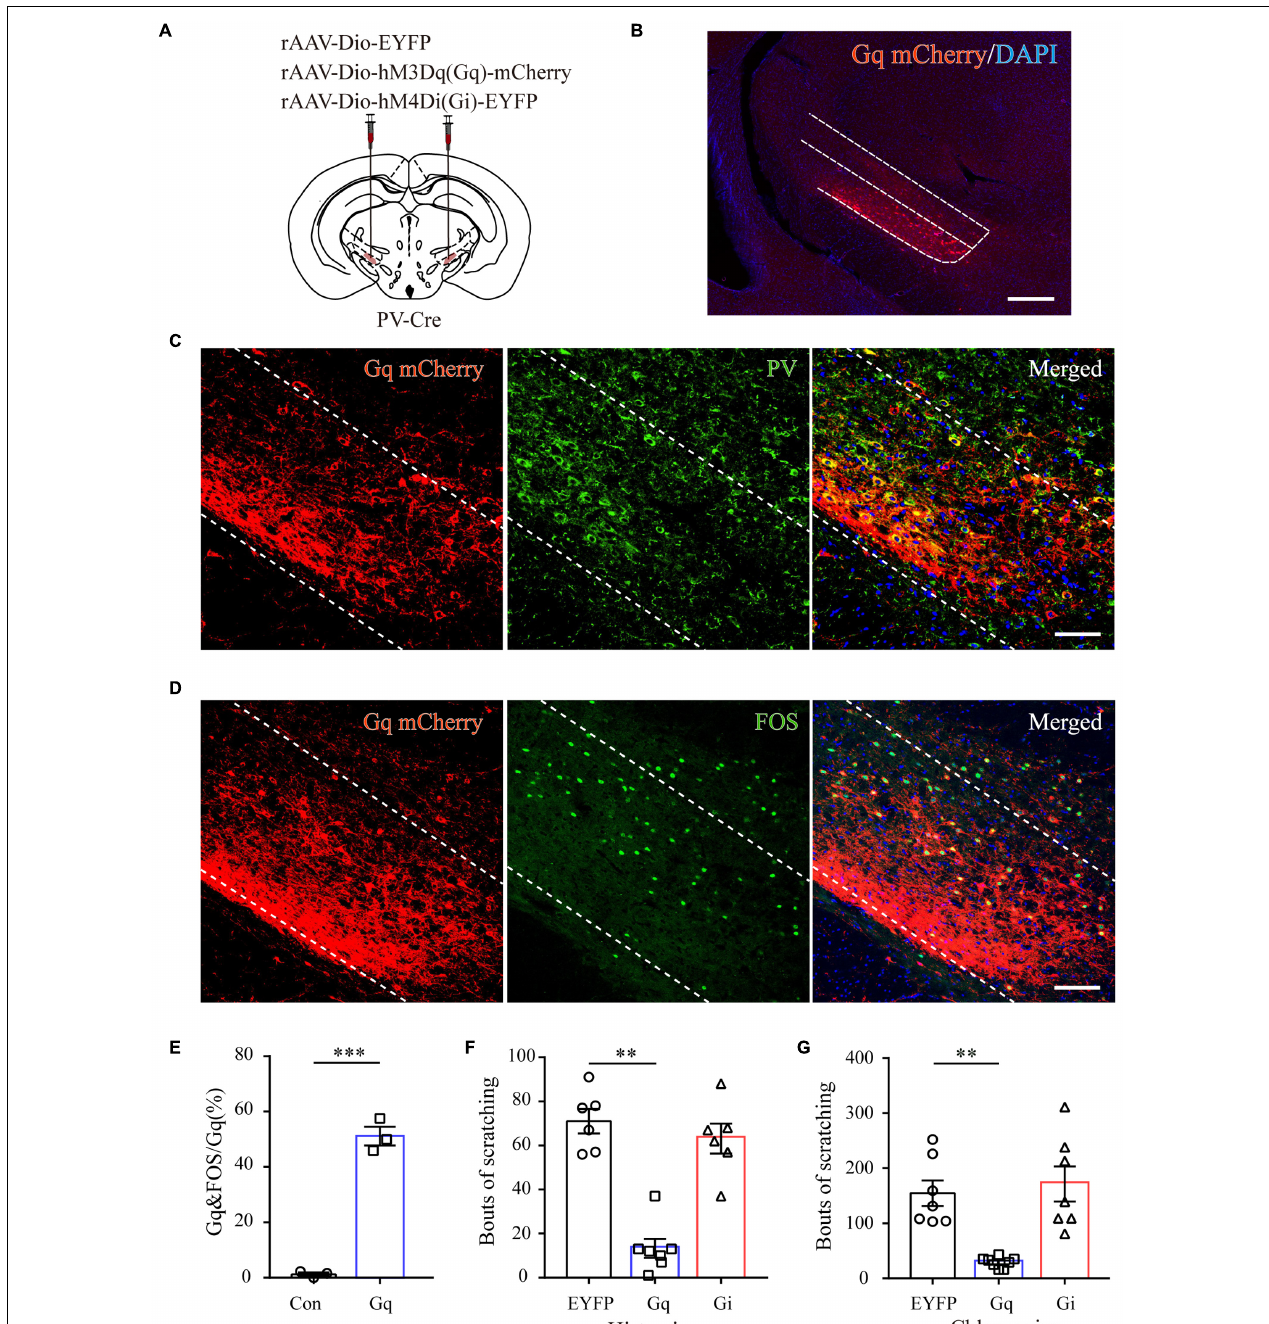
FIGURE 4 | ZI PV neurons negatively regulate scratching behaviors during acute itch. (A) Schematic illustration of viral injection for chemogenetic modulation of ZI PV neurons. (B) Histological verification of viral expression in the ZI in a representative mouse with AAV-DIO-hM3Dq-mCherry injection. Scale bar = 250 µ m. (C) Representative photographs showing the expression of PV (green) in hM3Dq-positive (red) neurons in the ZI of PV-Cre mice. (D) Representative photographs showing the expression of FOS (green) in hM3Dq-positive (red) neurons in the ZI of PV-Cre mice. (E) Quantification of FOS-expressing neurons in mice with AAV-hM3Dq and AAV-mCherry injection showed CNO injection increased FOS expression in ZI PV neurons in the mice in AAV-hM3Dq group. n = 3 mice per group, three sections per mouse. Unpaired T -test. t = –14.44, P < 0.001. (F,G) Chemogenetic activation of ZI PV neurons reduces scratching behaviors induced by histamine (F) and chloroquine (G) , while inhibition of them exerts no effect on scratching behaviors. One-way ANOVA with post hoc LSD test for multiple comparisons. For the analysis of histamine-induced itch, F (2,6) = 10.599, P = 0.001. n = 6 mice in EGFP and hM4Di groups and 7 in hM3Dq group. For the analysis of chloroquine-induced itch, F (2,6) = 13.341, P < 0.001. n = 6 mice in EGFP and hM4Di groups and 7 in hM3Dq group. n = 7 mice in EGFP and hM4Di groups and 8 in hM3Dq group. ∗∗∗ P < 0.001, ∗∗ P < 0.01.